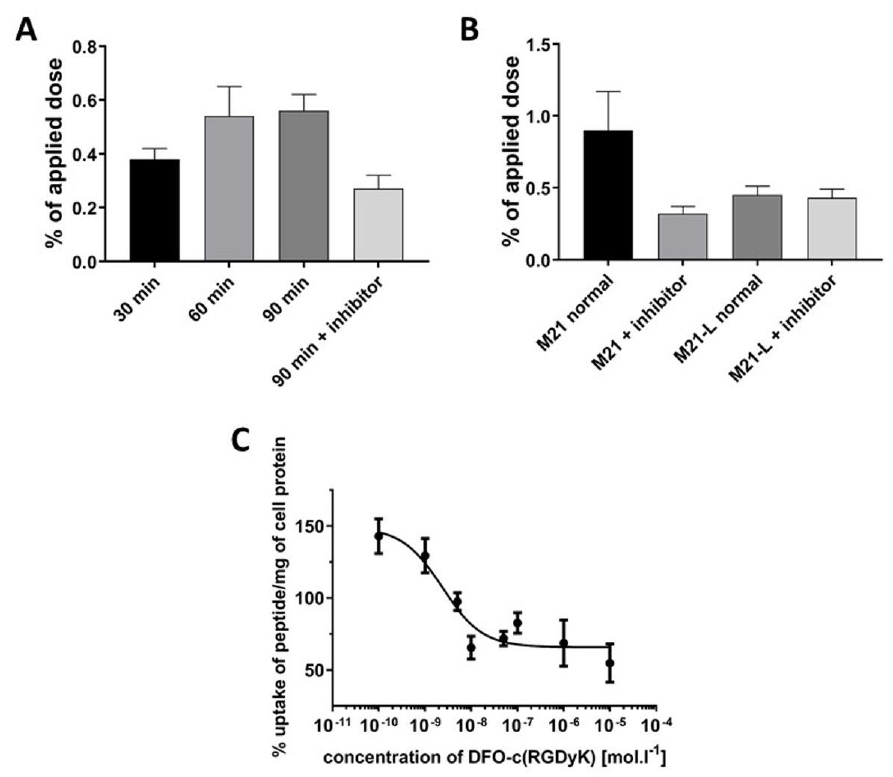
Figure 2. In vitro cell assays. The uptake of [ 68 Ga]Ga-DFO-c(RGDyK) in a U-87 MG cell line at various time points (30, 60, and 90 min) at 37 ◦ C, and the uptake inhibition by co-incubation with 500-fold excess of inhibitor (cold NODAGA-c(RGDyK)) ( A ). The uptake of [ 68 Ga]Ga-DFO-c(RGDyK) in M21 ( α v β 3-positive) and M21-L ( α v β 3-negative) cell lines without or with inhibitor (500-fold excess of cold NODAGA-c(RGDyK)) for 60 min at 37 ◦ C ( B ). Inhibition curve of [ 68